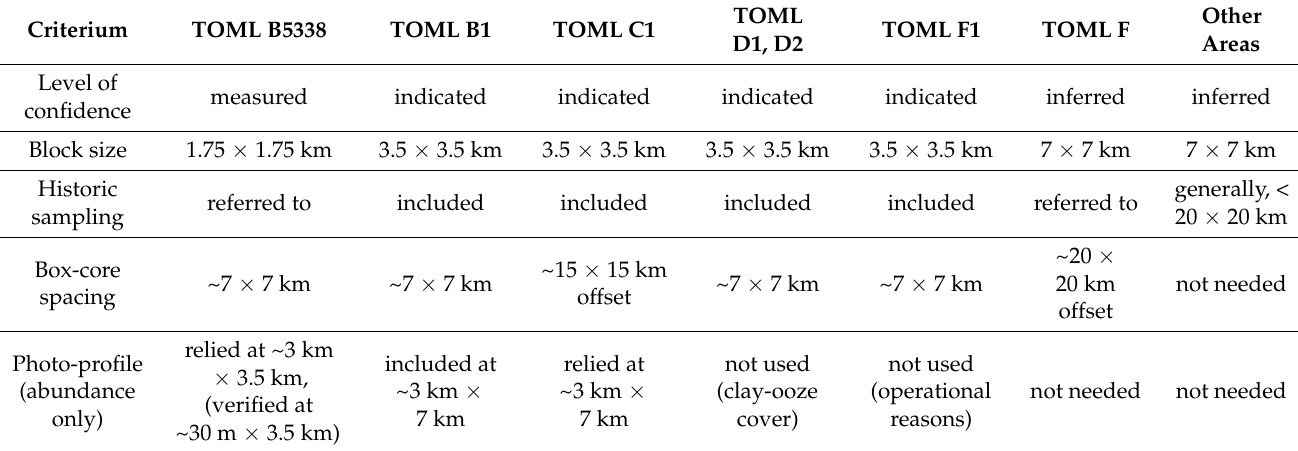
Table 3. Data matrix and confidence for the TOML mineral resource estimates in [12].